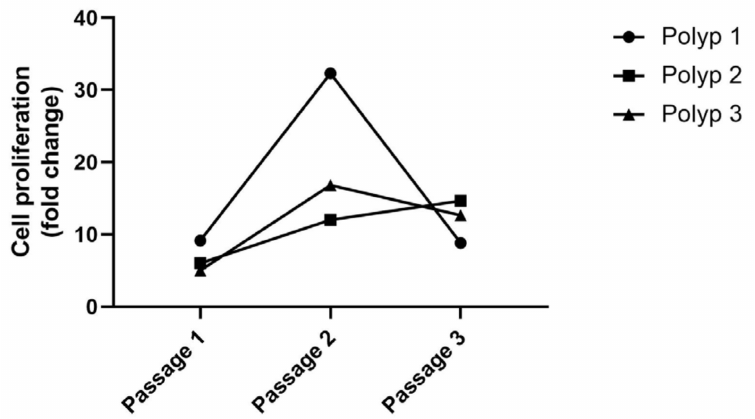
Figure 2. Fold change in cell number up to the 3rd passage. At the beginning of every passage, 30,000 cells were seeded. The number of total cells was counted after 6 days. The epithelial cells isolated from cryopreserved tissues showed a good proliferation rate up to the 3rd passage, approx- imately 5- to 32-fold. On day 6 of each passage, approximately 275,000, 970,500, and 264,000 cells were counted from Polyp 1; approximately 180,000, 360,000, and 440,000 cells from Polyp 2; and approximately 150,000, 505,000, and 380,000 cells from Polyp